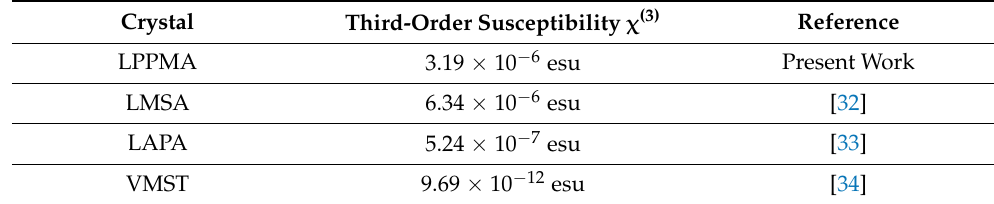
Table 4. χ (3) values of LPPMA comparison with new NLO